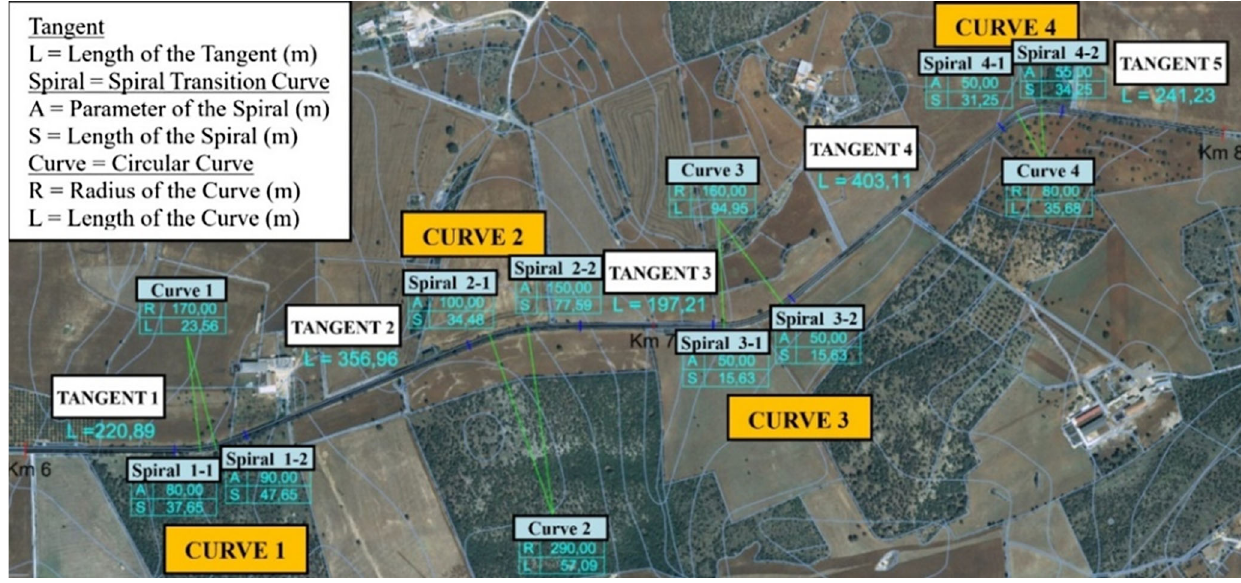
Fig. 4 Geometric reconstruction of site PP1 (horizontal